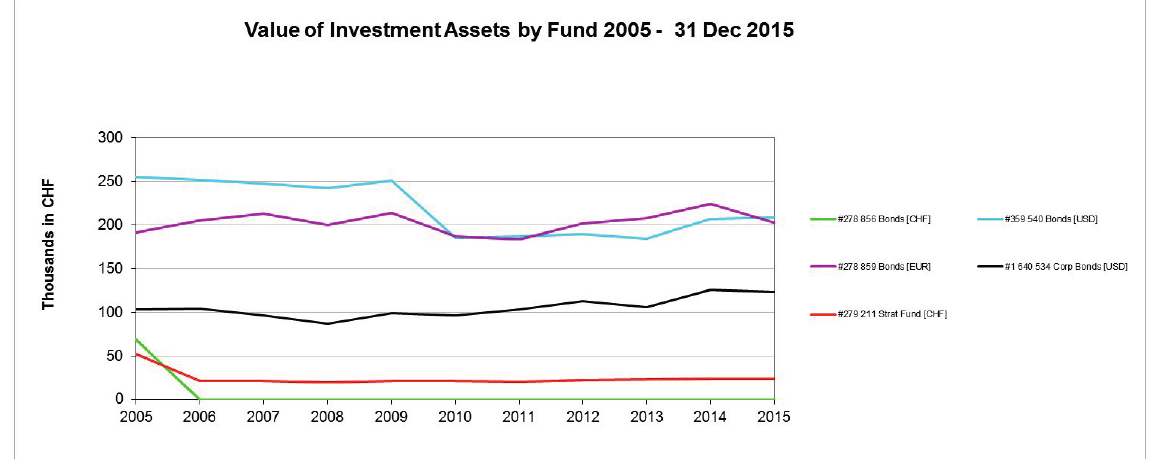
Figure 2: Value of ISPRS investment funds, 2005-2015.